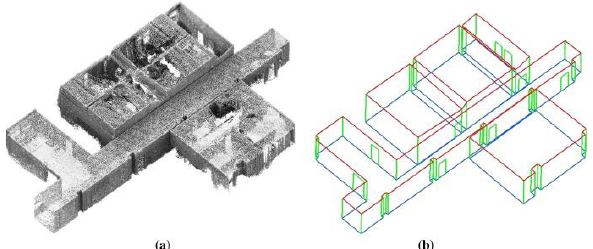
Figure 6. BIM feature examples. (a) Point cloud data. (b) BIM structure model. The green lines are doors and pillars. The red lines are ceilings. The blue lines represent the ground.